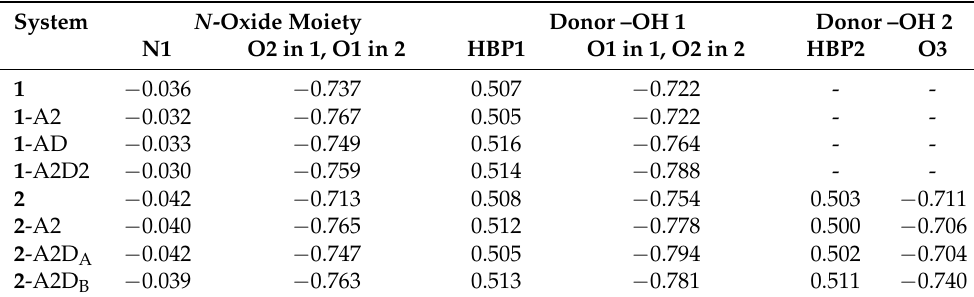
Table 2. NBO atomic charges for the atoms involved in hydrogen bonding network, calculated at the ω B97XD/6-311++G(d,p) level of theory for the microsolvation models.